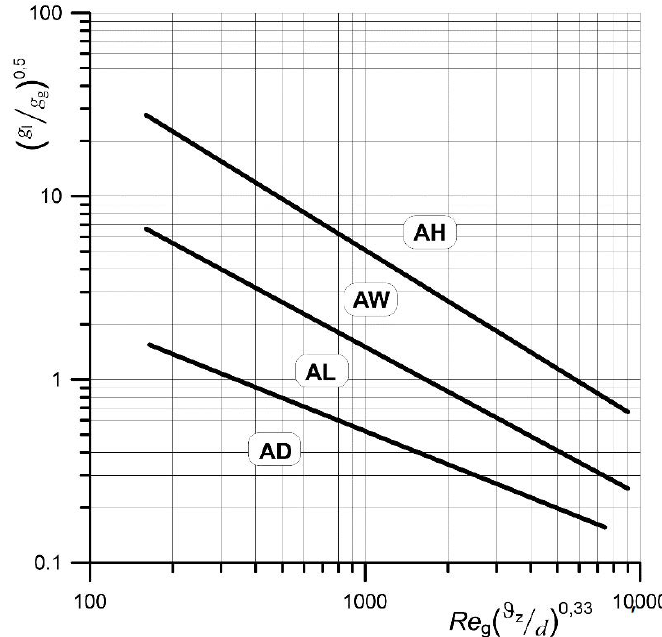
Figure 10. Universal map of annular descending two-phase flow of gas and very viscous liquid in vertical pipes.